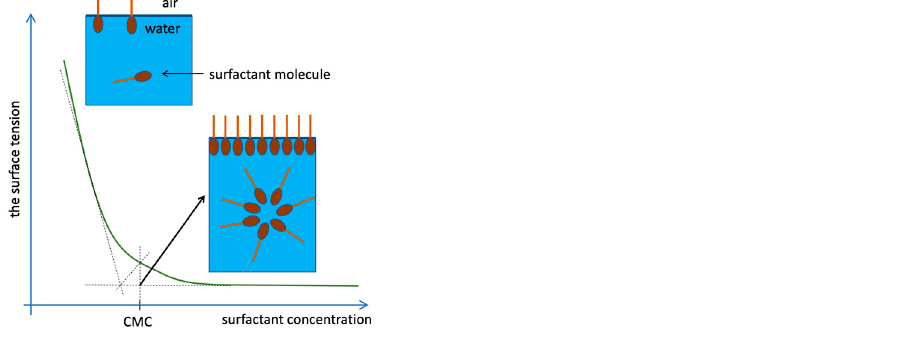
Figure 2. Arrangement of surfactant molecules in the solution depending on the concentration [17].